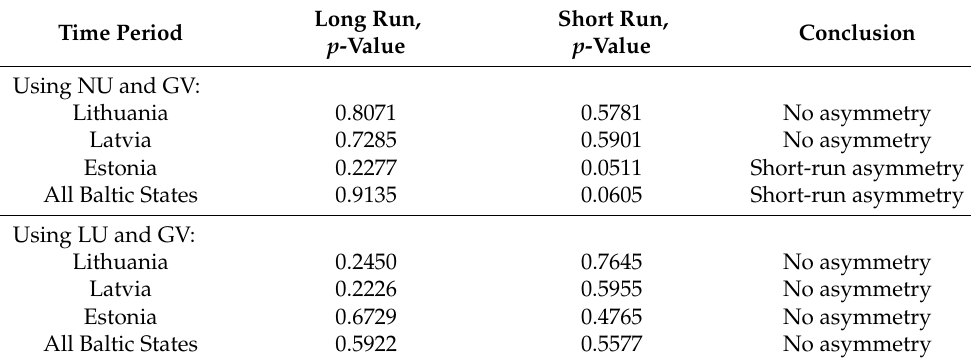
Table 4. Results of tests for long- and short-run